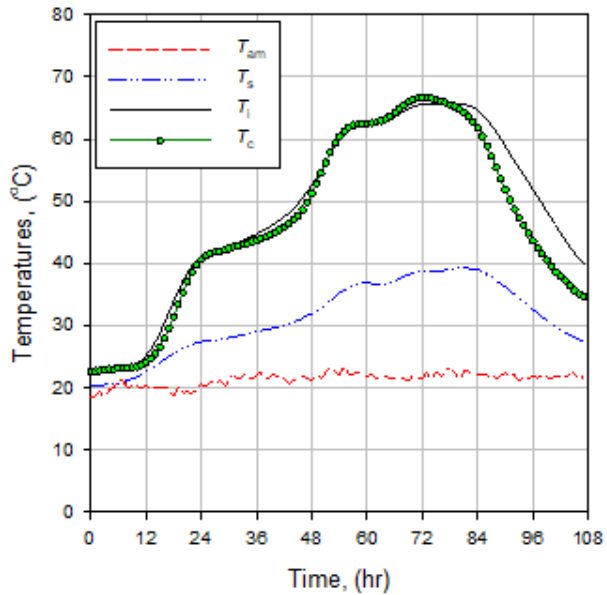
Figure 5. Time course of temperatures measured for the ambient air ( T am ), outer surface of reactor ( T s ), inner surface of reactor ( T i ) and compost ( T c ) during the composting process.